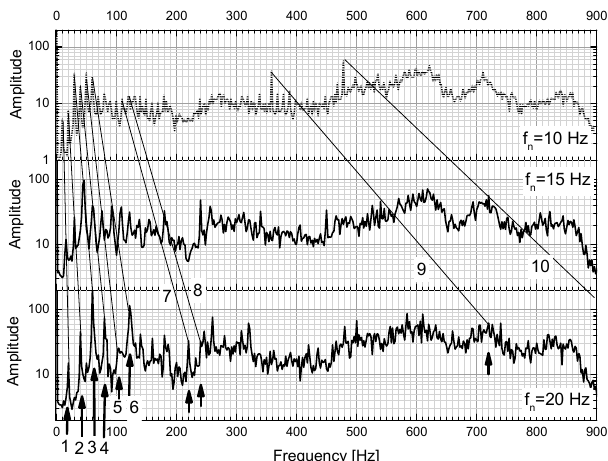
Figure 3. Amplitude spectra of FXLN accelerometer in radial ( y -axis) direction with varying rotation speed from 10 (~50 mm/s) to 20 Hz (~100